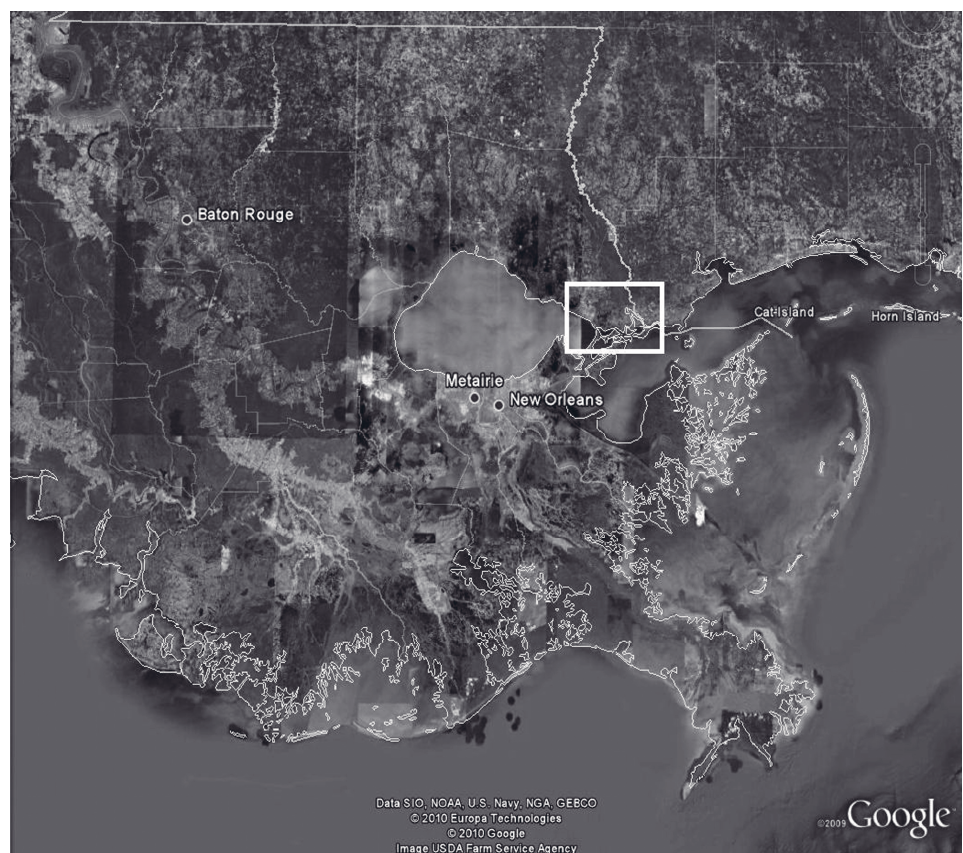
Figure 1. Aerial Image of Las Conchas Marsh (Google Earth 2008) with four sampling sectors highlighted; Low Zone, Ditch 1, Salt Bayou, and Ditch 5. This image accompanied by a southeast Louisiana map showing relative area of study site in highlighted